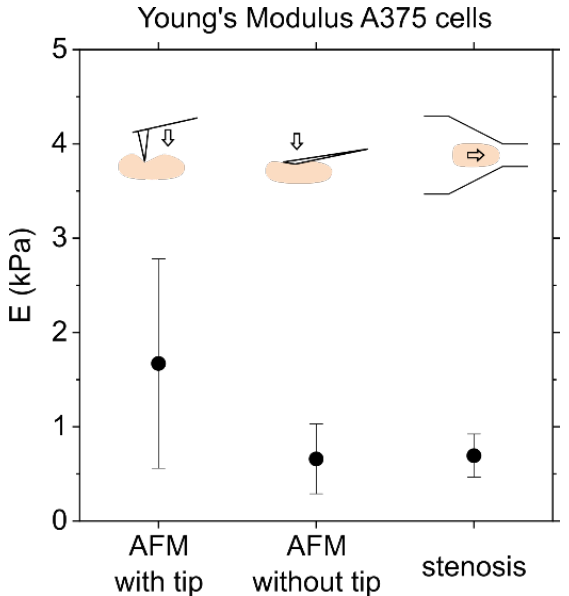
Figure 7. Comparison of AFM and microfluidic deformation analysis of the Young ’ s modulus of A375 cells. AFM: The result of AFM measurements with and without tip is the mean and standard deviation from measurements on 5–15 cells with ≈ 10 force curves per cell. Stenosis: Elasticity was also determined based on deformation under flow during the passage of a stenosis. The value here summarizes the six values from Figure 5, each of which relies on trajectories from approximately 2500 cells.